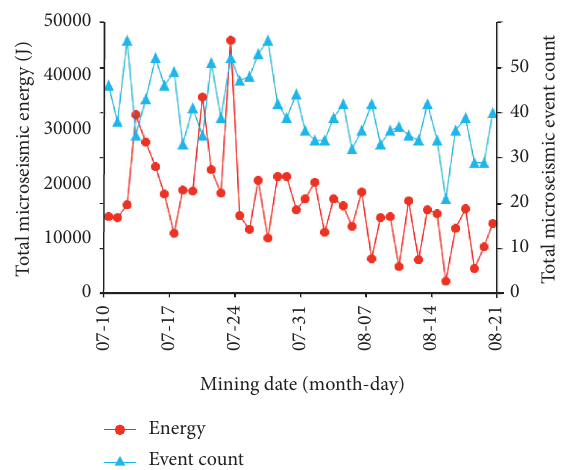
Figure 18: Microseismic monitoring data analysis chart (III-III section).